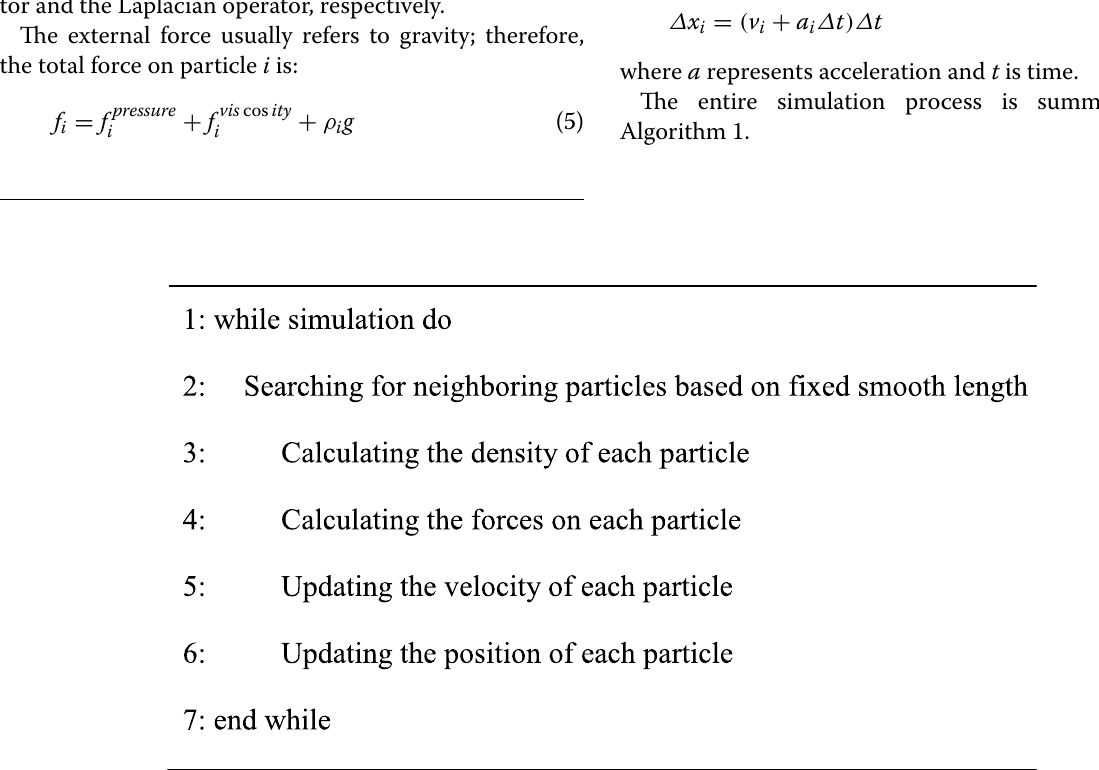
Algorithm 1 Overview of traditional SPH method